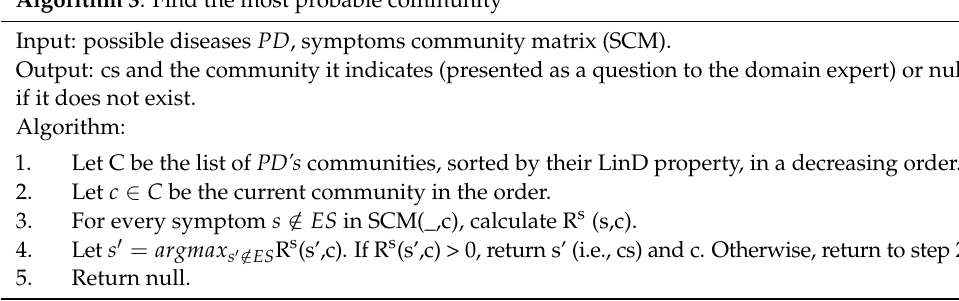
Algorithm 3 : Find the most probable community